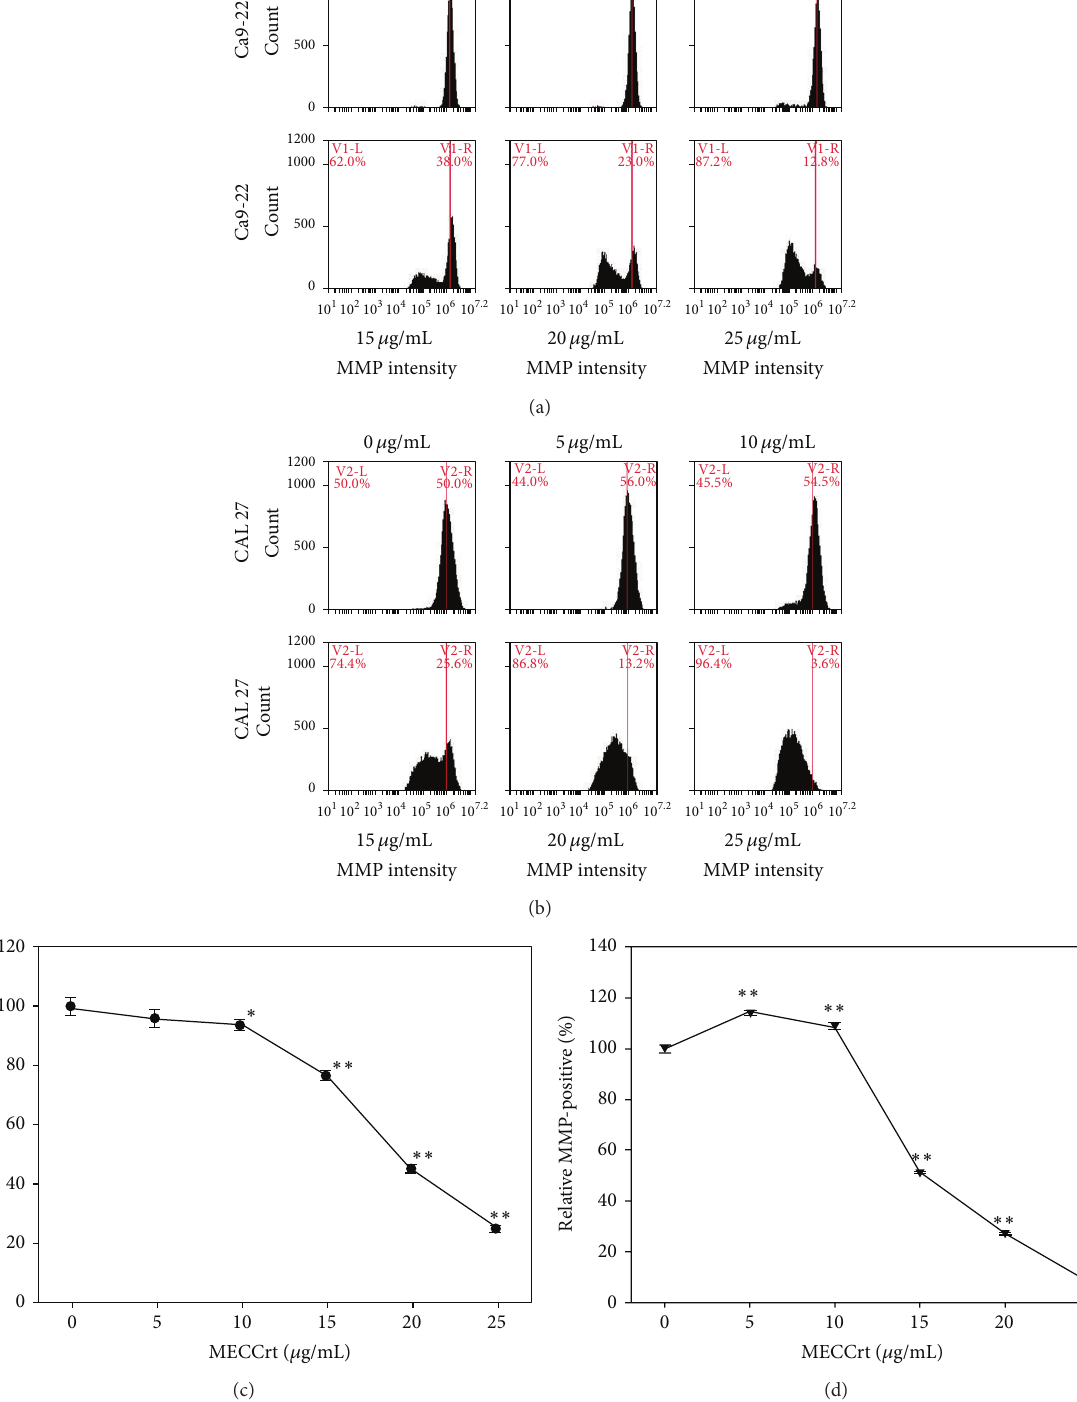
Figure 5: Depolarization of mitochondrial membrane potential (MMP) of Ca9-22 and CAL 27 oral cancer cell lines was induced by MECCrt. Oral cancer Ca9-22 and CAL 27 cell lines were treated with different concentrations (0–25 𝜇 g/mL) of MECCrt for 24 h. ((a), (b)) Representative MMP profiles of flow cytometry for MECCrt-treatedoral cancer Ca9-22 and CAL 27 cells. ((c) and (d)) Quantification analysis of relative MMP intensity in (a) and (b), respectively. Data, means ± SDs ( 𝑛 = 3 ). ∗ 𝑃 < 0.05 and ∗∗ 𝑃 < 0.01 against